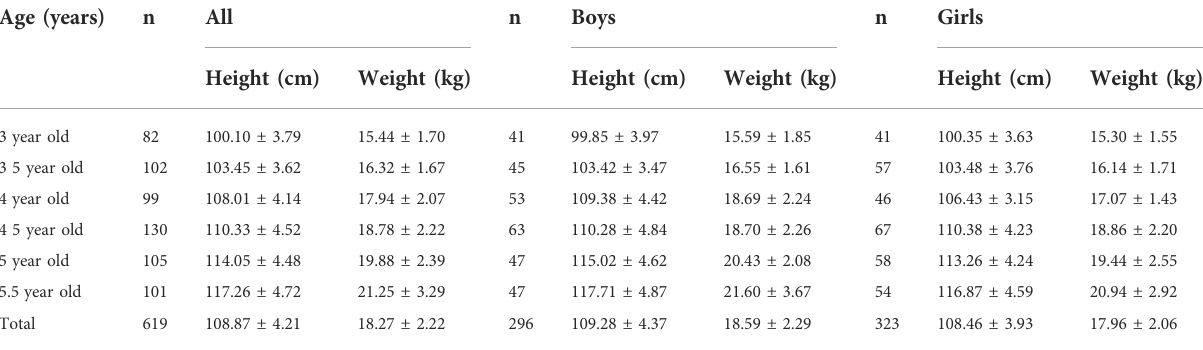
TABLE 1 Descriptive characteristics of the